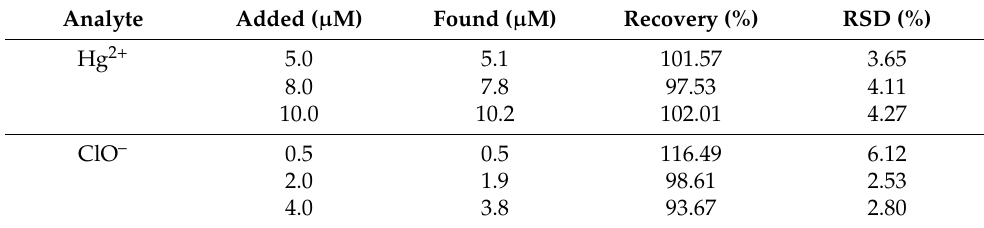
Table 1. Determination of Hg 2+ and ClO − ions in tap water samples ( n = 3).